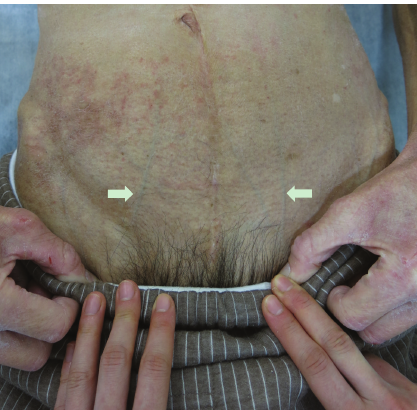
Figure 1: Distention of the bilateral superficial epigastric veins (arrows).